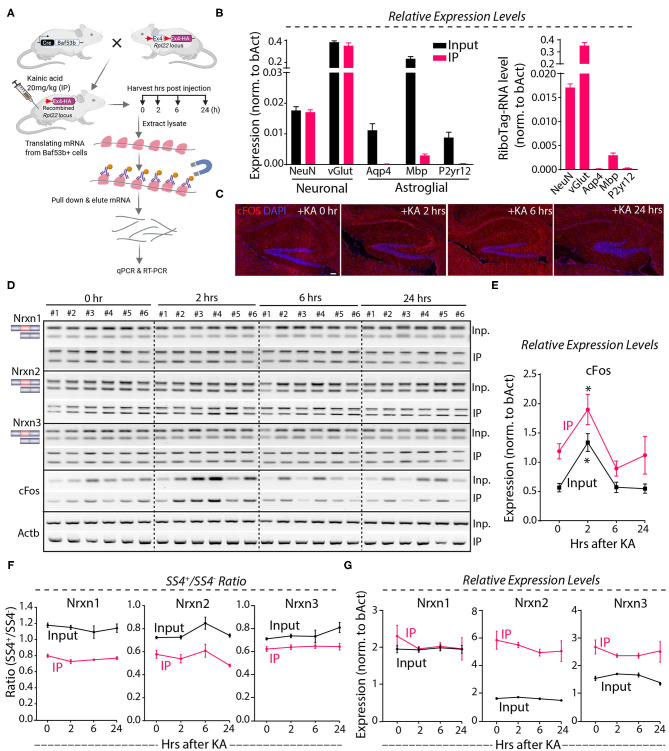
KA-induced activity followed by neuronal specific mRNA enrichment using Baf53b-Cre x RiboTag approach show no change in Nrxn SS4 alternative splicing. (A) Baf53b-Cre x RiboTag experimental paradigm. Mice expressing Cre under neuronal-specific Baf53b promotor crossed with RiboTag mice. Adult mice heterozygous for both alleles received 20 mg/kg KA intraperitoneally. Hippocampus harvested at indicated time points. Poly-ribosome bound mRNA isolated using immunoprecipitation (IP) with HA beads and used for subsequent qPCR and RT-PCR. (B) Quality control qPCR shows enrichment of neuronal markers and de-enrichment of astroglial markers. (C) Microscopic images of IHC in the hippocampus shows KA-induced cFos expression at 2 h post-injection. (D) RT-PCR shows Nrxn SS4 splicing and cFos expression in IP and input samples in six mice in each time point. (E) Quantification of relative expression of cFos show high level in IP compared to input mRNA. Significant induction of cFos at 2 h in both IP and input samples shown [* = p 0.0103 (IP), * = p 0.0191 (input)]. (F) Quantification of Nrxn SS4 splicing ratio shows marked difference between IP and input mRNA but no significant difference within IP or input samples across different time points (G) Quantification of Nrxn relative expression levels show general difference in IP and input mRNA, except for Nrxn1 but no significant difference with in IP or input samples across different time points. All numerical data are represented as means ± SEM. Statistical significance was calculated by two-way ANOVA using Sidaks's multiple comparison test. Scale bar 100 μm.